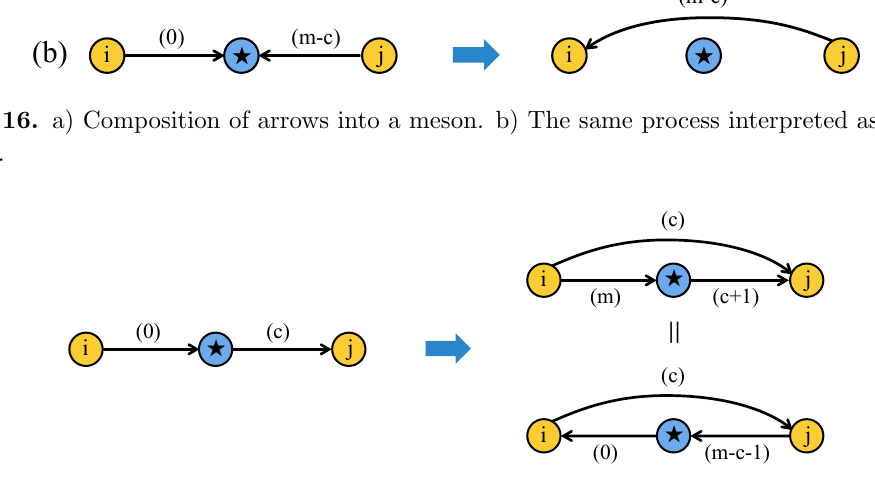
Figure 17. New cubic terms coupling mesons to dual